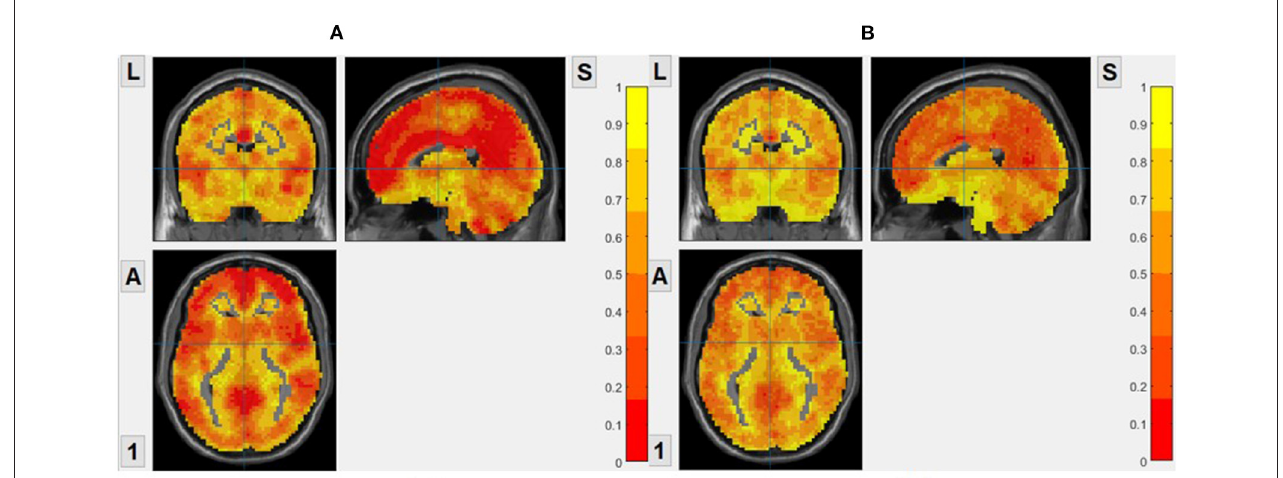
FIGURE 1 | The brain entropy distribution of a normal subject. (A) ApEn, based on voxel, m = 2, r = 0.2. (B) FuzzyEn, based on voxel, m = 2, r =